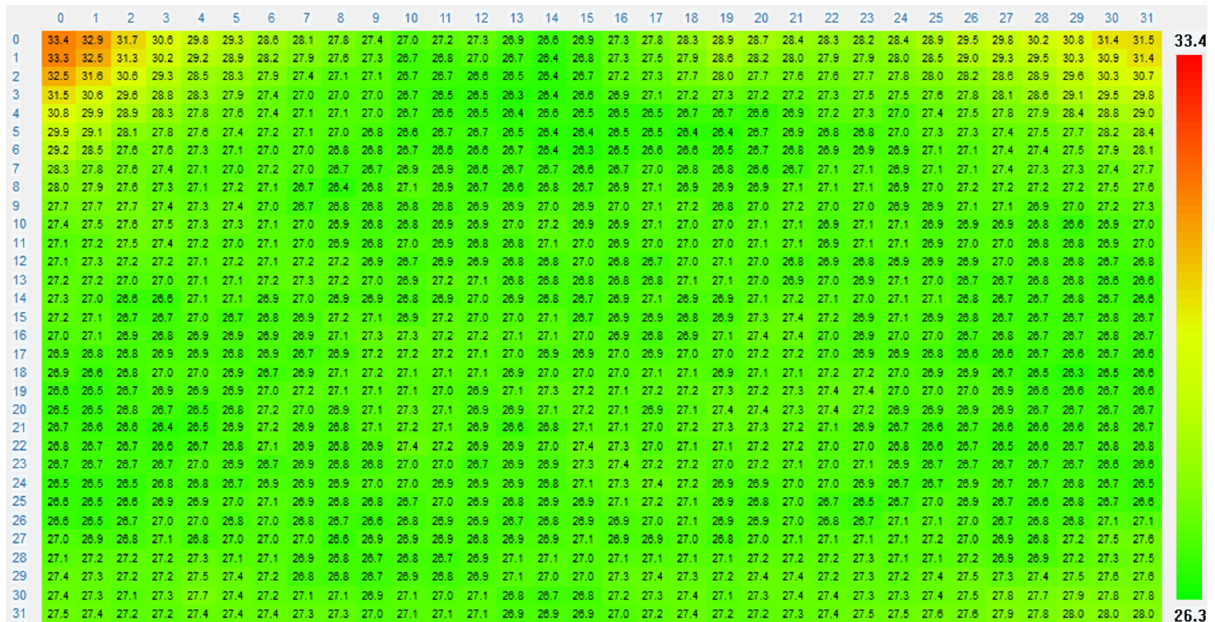
Figure 8. Noise is suppressed by the first-order low-pass filter.